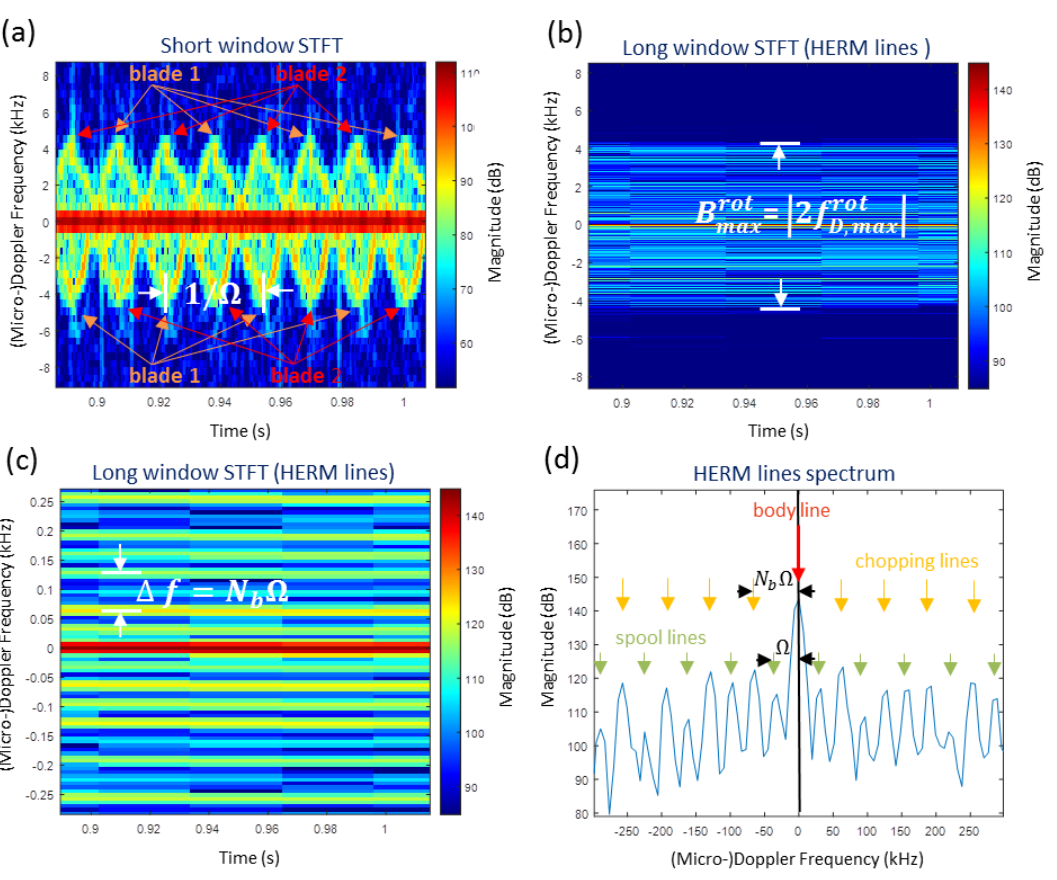
Figure 4. Example of a measured micro-Doppler spectrogram of the coaxial helicopter by W-band radar using ( a ) short window STFT and ( b ) long window STFT; ( c ) zoomed into the long window STFT showing individual HERM lines; ( d ) HERM lines spectrum at 1